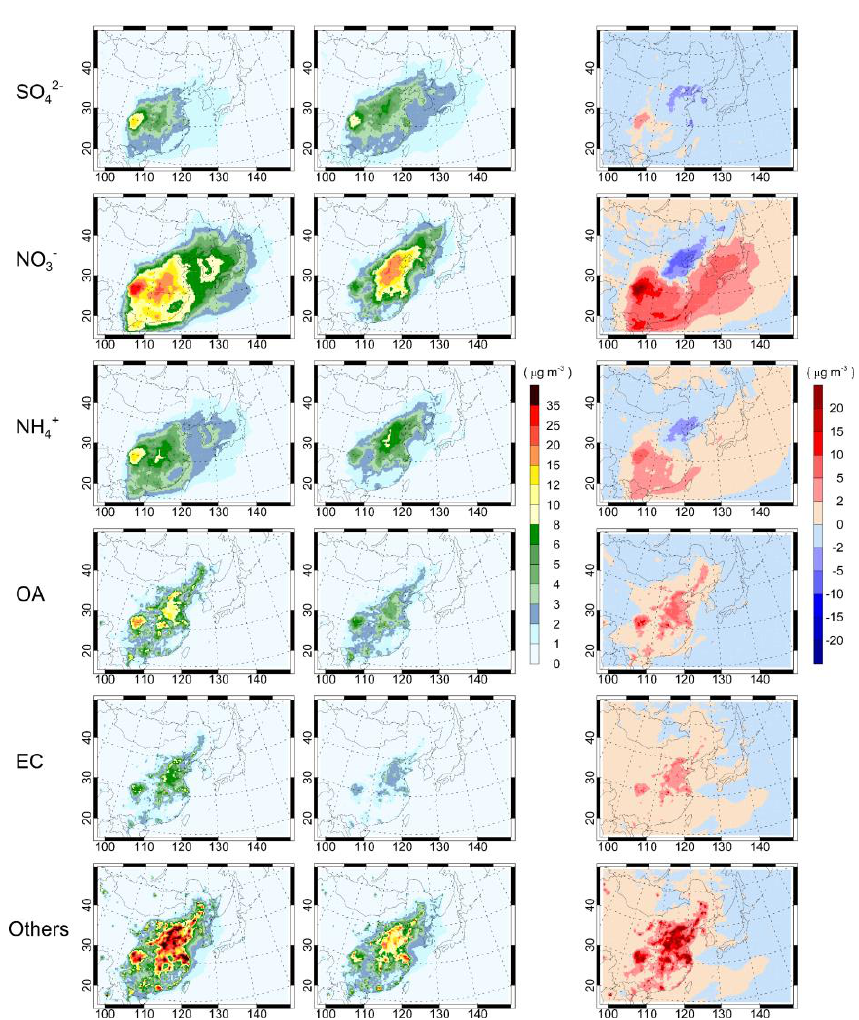
Figure 7. Spatial distributions of the surface PM 2.5 chemical components simulated by the WRF-Chem (left panels) and WRF/CMAQ (middle panels) models and their concentration differences (right panels). The concentration differences were calculated by C WRF-Chem – C WRF/CMAQ .